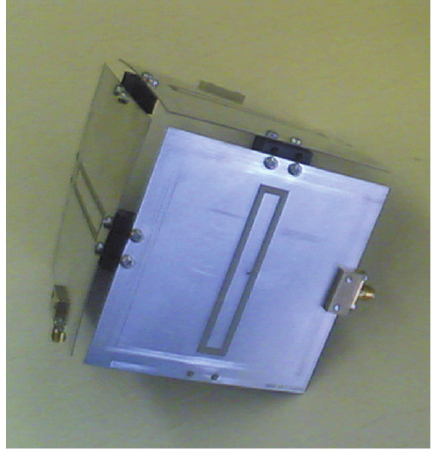
Figure 16: 3 antennas on the mid of the